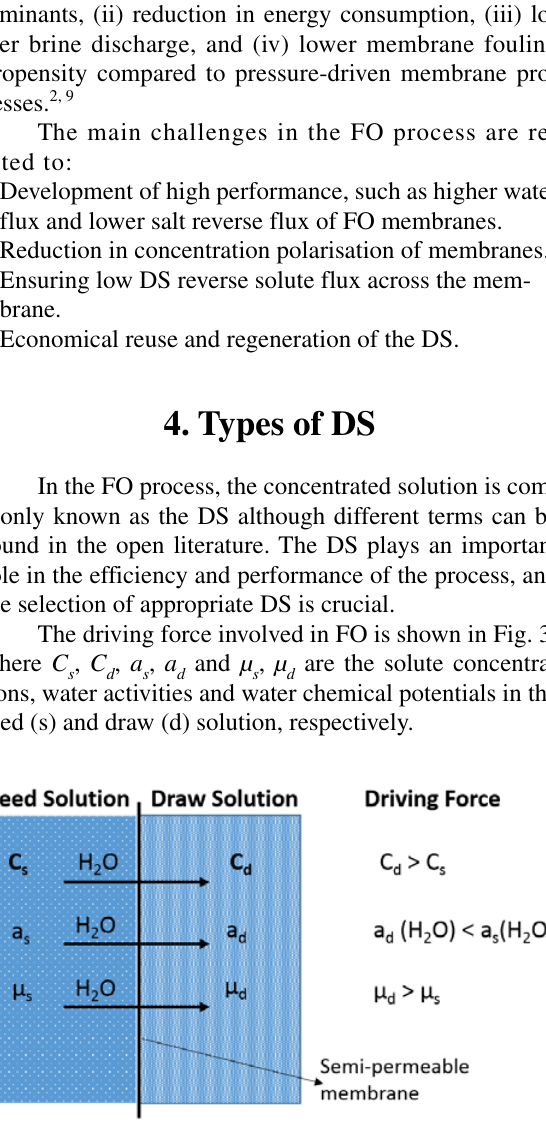
O) is transported across 2